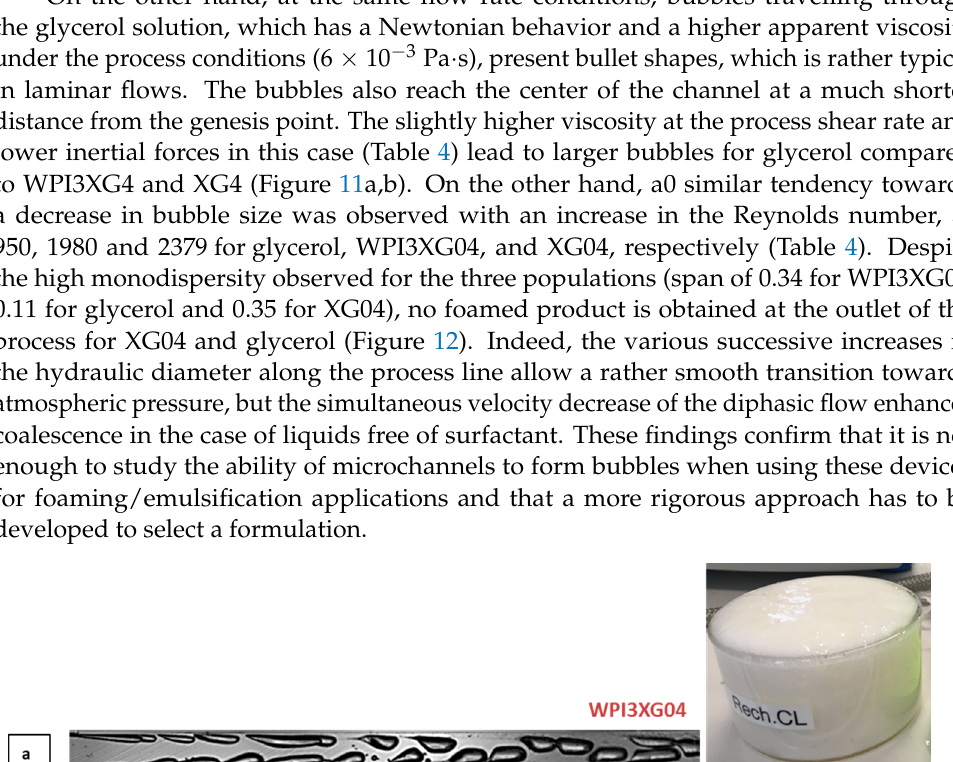
and Q mG = 21.6 g · h − 1 . ( b ) Bubble size distribution in cumulative volume for bubbles inside the mixing channel of CX600 for solutions WPI3XG04, XG04 and glycerol at Q vL = 11 L · h − 1 and Q mG = 21.6 g · h − 1 . The diameters of bubbles inside the microchannels are normalized to the atmospheric pressure. ( c ) High-speed visualizations of the two-phase flow inside the expansion channel of the device CX-E-600 for solutions WPI3XG04, XG04 and glycerol at Q vL = 3 L · h − 1 and Q mG = 5 g · h − 1 . Table 4. Hydrodynamic parameters of the two-phase flow in the mixing channel of the microfluidic device CX600 for the XG04, WPI3XG04 and glycerol solutions at Q vL = 11 L · h − 1 − Q mG = 21.6 g · h − 1 . Solution